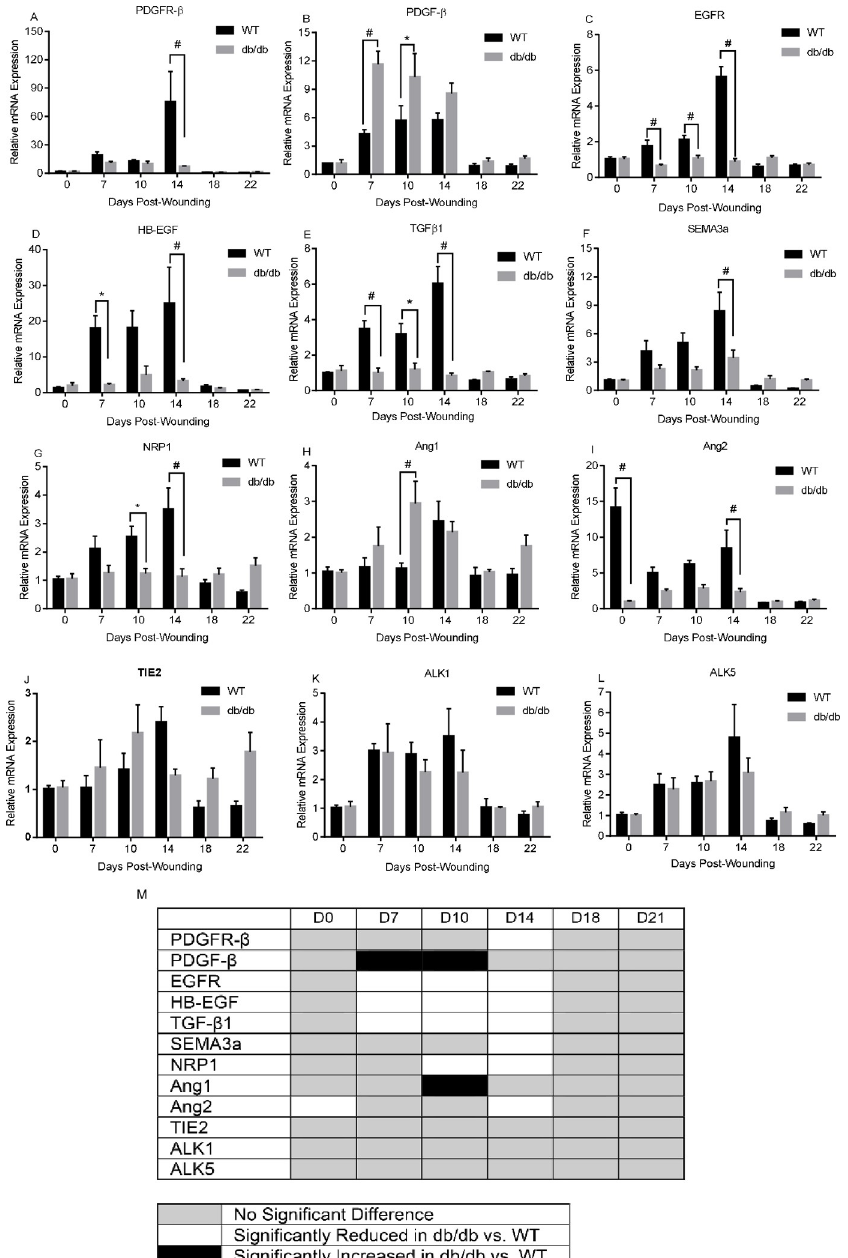
Fig 4. A-L) Semi-quantitative RT-PCR analysis of capillary pericyte recruitment and stabilization factors in wounds over the time course of wound healing. n = 5, � p > 0.05, #p < 0.01. M) Heatmap summarizing findings of A-L, showing genes with no difference (gray boxes) significant downregulation (white boxes) or upregulation (black boxes) over the time course of healing in db/db versus WT mice. In the figure, factors are identified using common protein name abbreviations; for gene symbols see Table